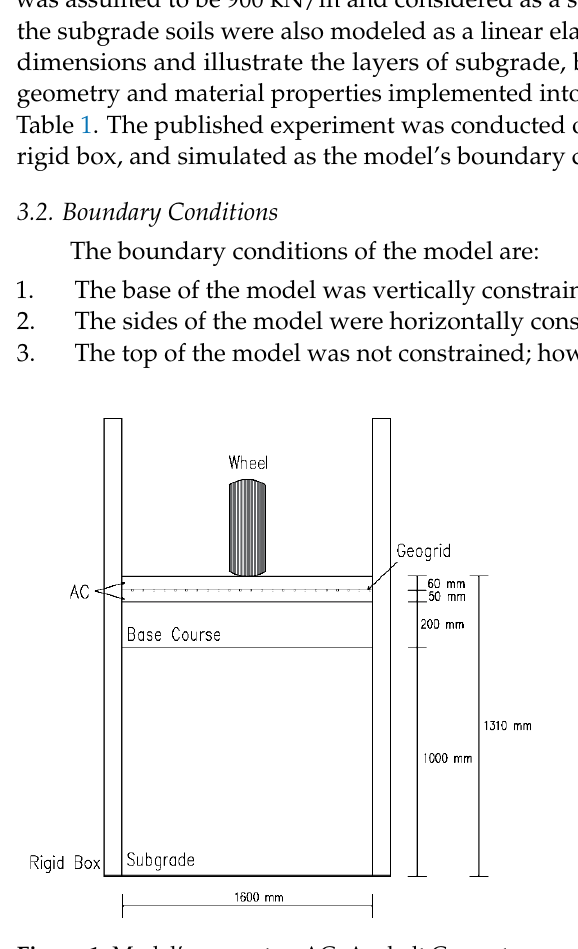
Figure 1. Model’s geometry. AC: Asphalt Concrete.